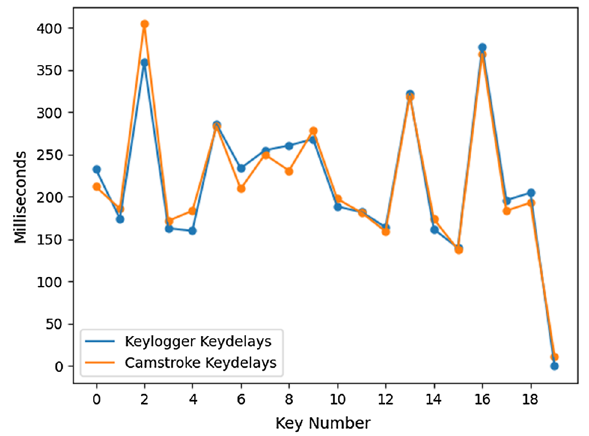
Fig. 10 KeyDelay comparison on password phrase sample